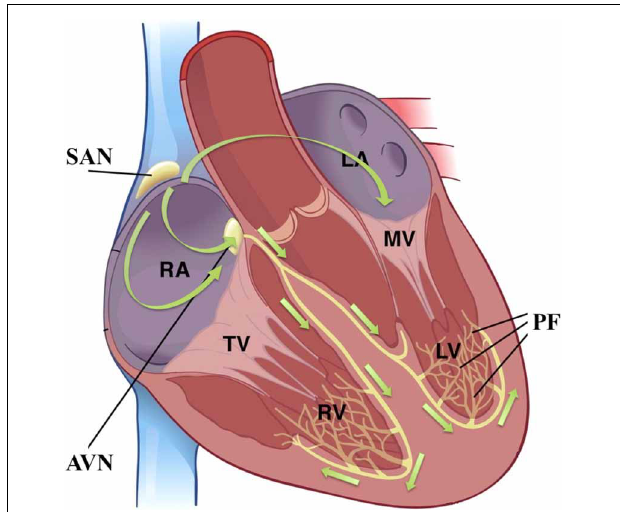
FIGURE 2 | (A) Model schematic of the Noble 1962 model, where the Purkinjecellmembraneisrepresentedasanelectricalcircuit[Figuremodified from (18)]. (B) Simulated AP and ion currents using the Noble 1962 Purkinje cell model to illustrate the I K 2 “decay” hypothesis. Black arrows indicate the depolarization and repolarization phases during an AP. Blue arrows indicate the shift between inward and outward current balance during the DD that finally triggers a spontaneous